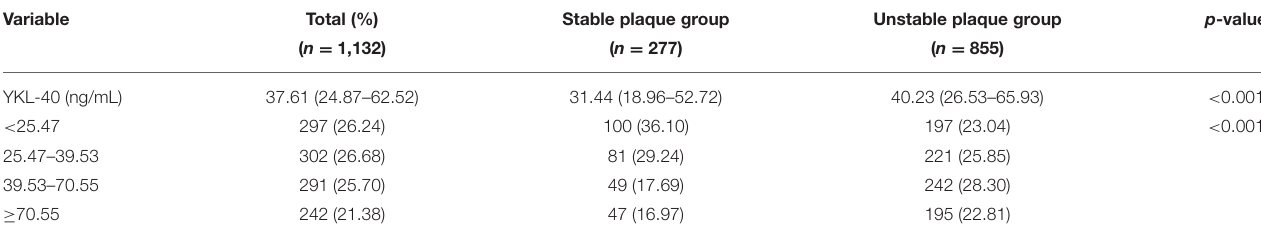
TABLE 2 | Comparison of YKL-40 levels between stable and unstable plaque groups. Variable